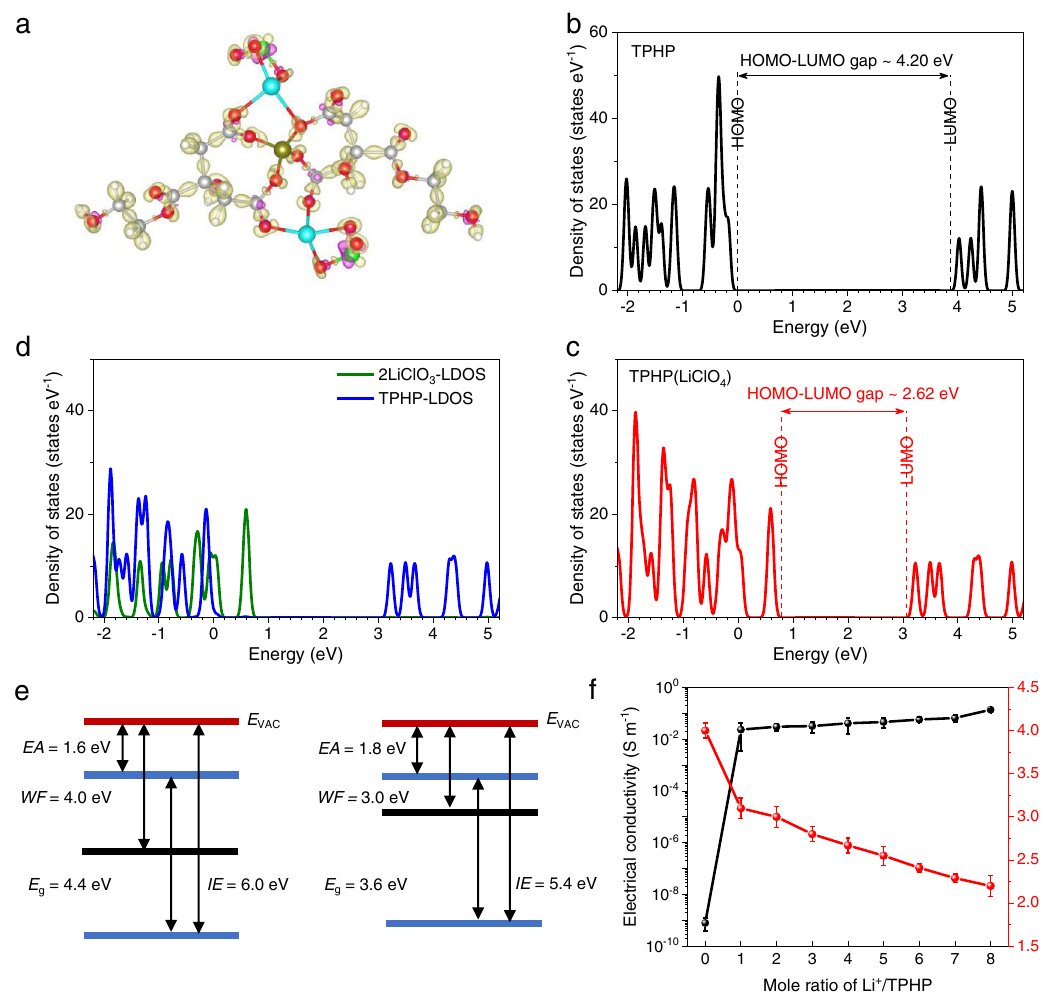
Fig. 2 | Electronic structure and properties of TPHP(LiClO 4 ). a Charge density differenceplotsforTPHP(LiClO 4 ).Theisosurfacevaluewassettobe0.04eÅ − 3 ,the charge accumulated and depleted regions were shown in yellow and purple, respectively, clearly showing the electron transfer from ClO 3 − to TPHP. b , c Calculated density of states (DOS) of TPHP ( b ) and TPHP(LiClO 4 ) ( c ), in which the HOMO level was set to be aligned with WF . d Calculated local DOS (LDOS) of 2LiClO 3 (greenline)andTPHP(blueline)inTPHP(LiClO 4 ). e Energylevelalignment